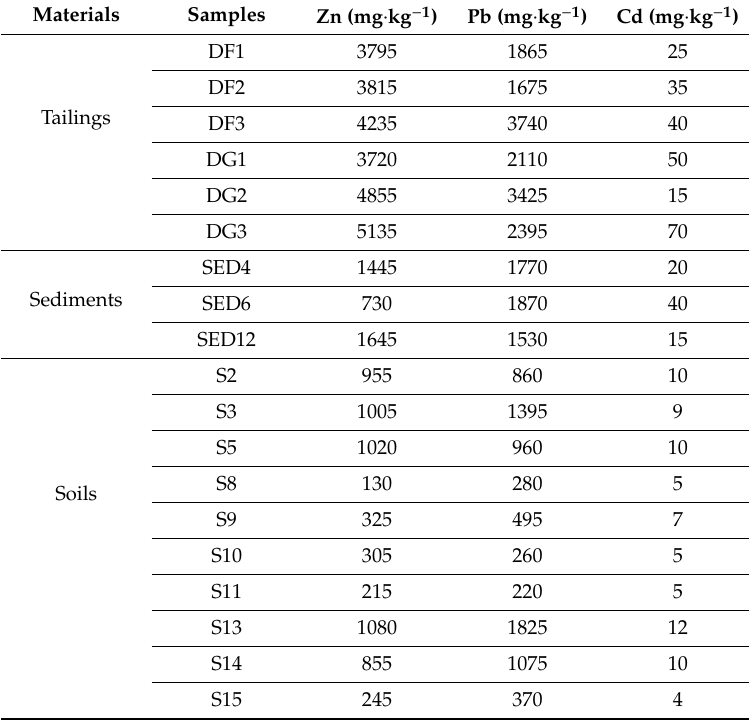
Table 1. Total concentrations of the potentially toxic elements (PTEs) in the selected tailings, sediments and soil